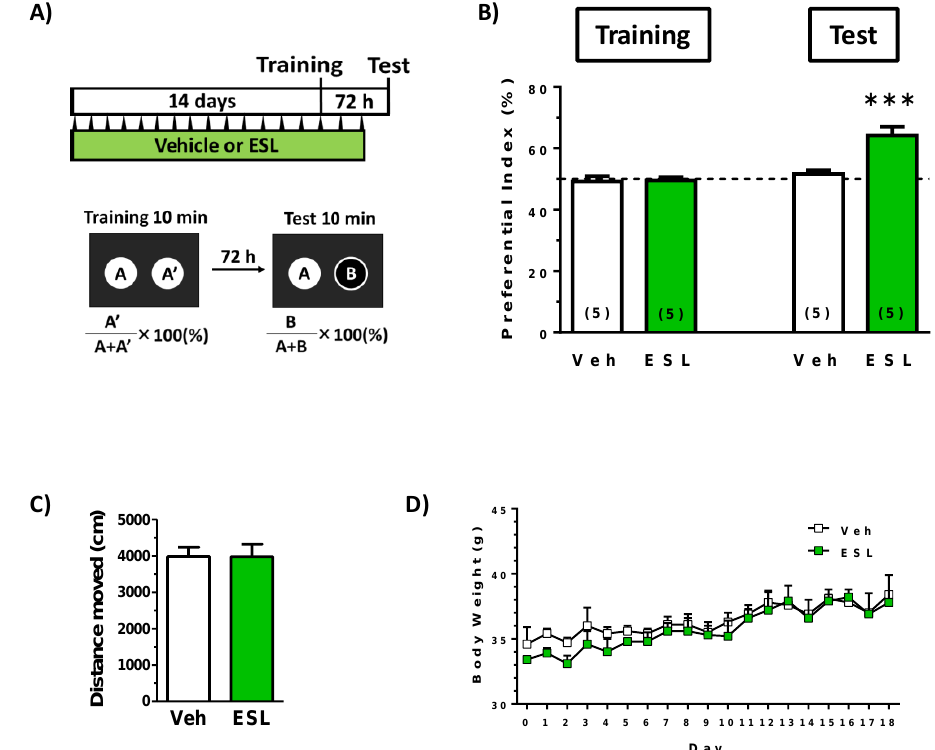
Figure 1. E ff ects of the leaf extract of E. senticosus on object recognition memory in mice. ( A ) The leaf extract of E. senticosus (500 mg / kg, p.o.) (ESL) or vehicle solution (Veh) was administered for 17 days to mice (males, 8 weeks old). On administration day 14, an object recognition test was started. ( B ) The preference indices of the training and test sessions are shown. Above 50% of the preferential index in a test session shows memory enhancement. (*** P < 0.001, repeated measures two-way ANOVA, post hoc Bonferroni test; n = 5 mice). ( C ) Locomotion was evaluated as moved distances for 10 min in an open field box on day14. Statistical analysis was done by one-way ANOVA. P > 0.05. ( D ) Body weights in two groups were measured and analyzed by repeated measures two-way ANOVA. P >